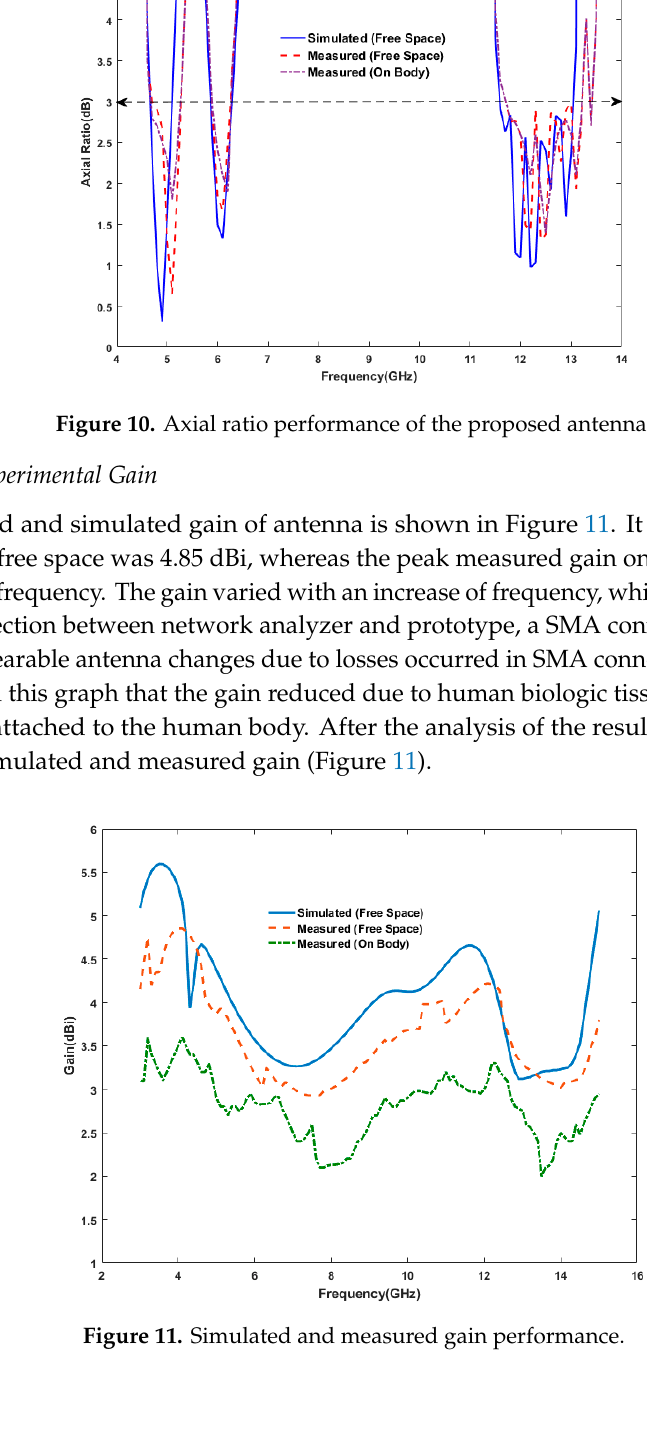
Figure 11. Simulated and measured gain performance.